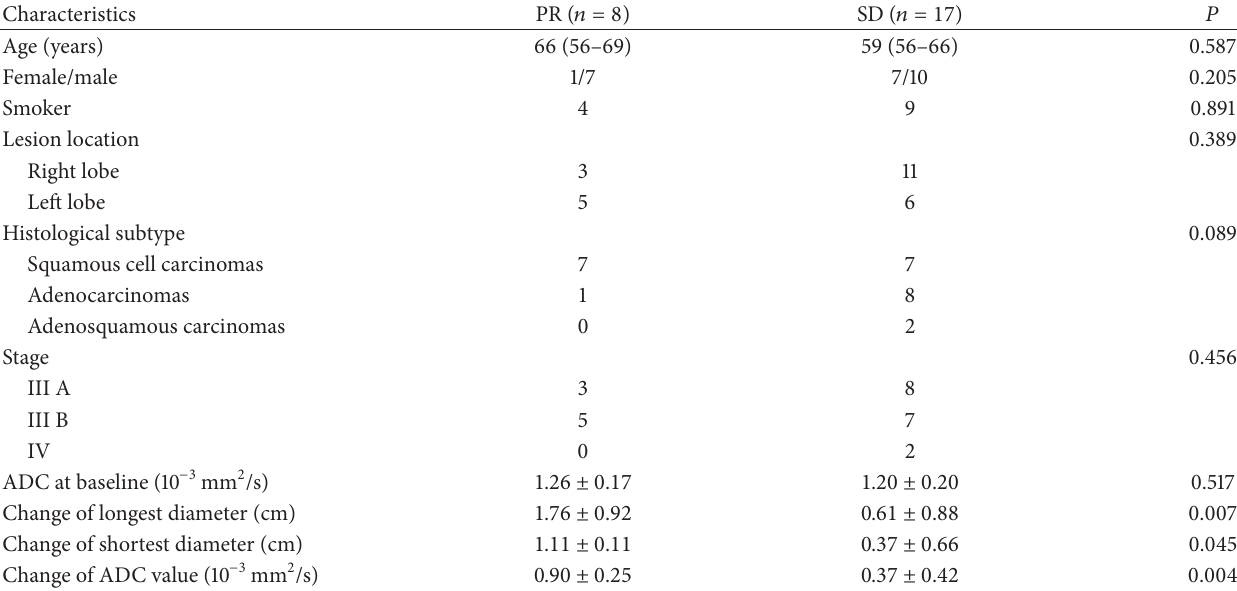
Table 1: Patient and tumor characteristics between the PR and SD groups.